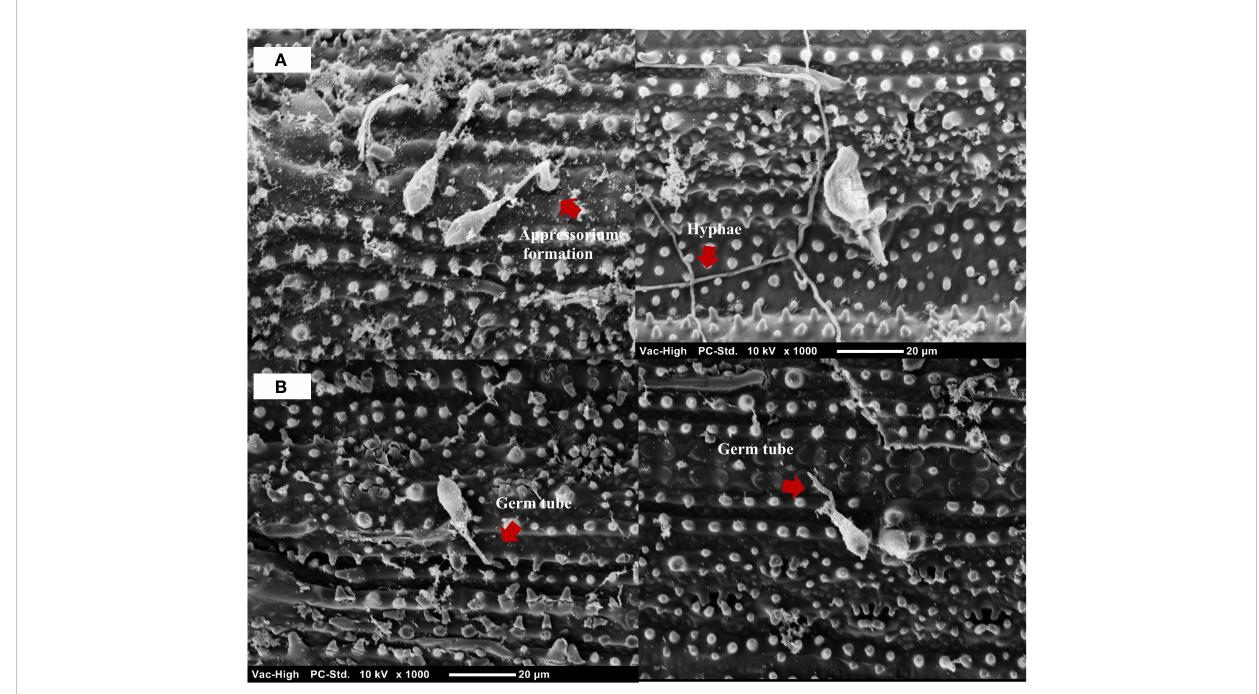
FIGURE 9 Scanning electron micrograph of Magnaporthe oryzae on detached rice leaves at 24 hpi. (A) M. oryzae successfully established appressoria and hyphae on the leaves of the untreated rice plant. (B) M. oryzae conidia adhesion on the leaves of Bacillus vallismortis – treated rice